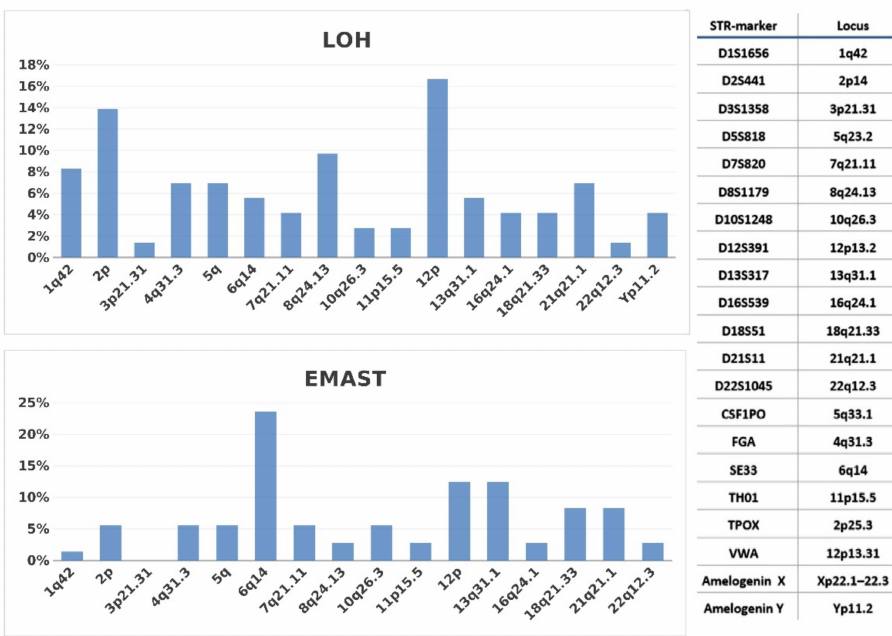
Figure 1. Diagram of LOH and EMAST distribution in STR-loci among 72 PMBCL patients. Twenty-four patients had a combination of EMAST with LOH. Samples of the LOH and EMAST aberrations in the STR loci are presented below (Figure